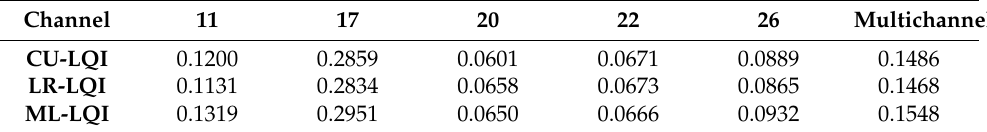
Table 6. RMSEs of the models of RSSI and PRR under single-channel and multichannel scenarios.